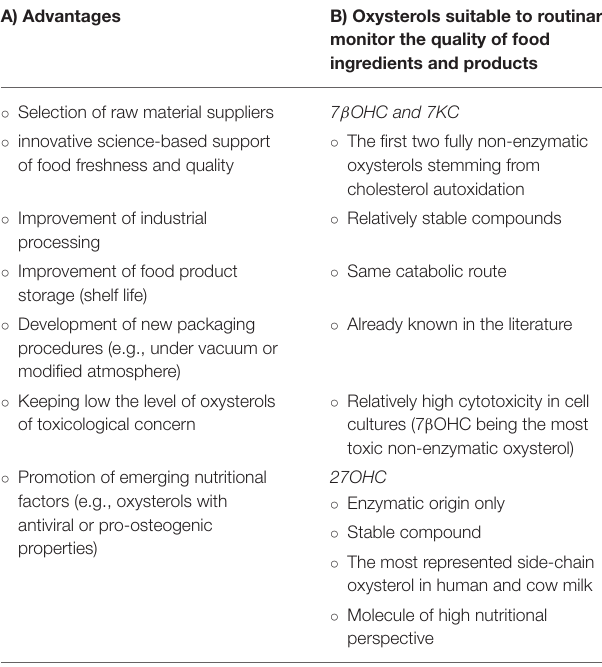
TABLE 1 | Oxysterols as quality markers in food